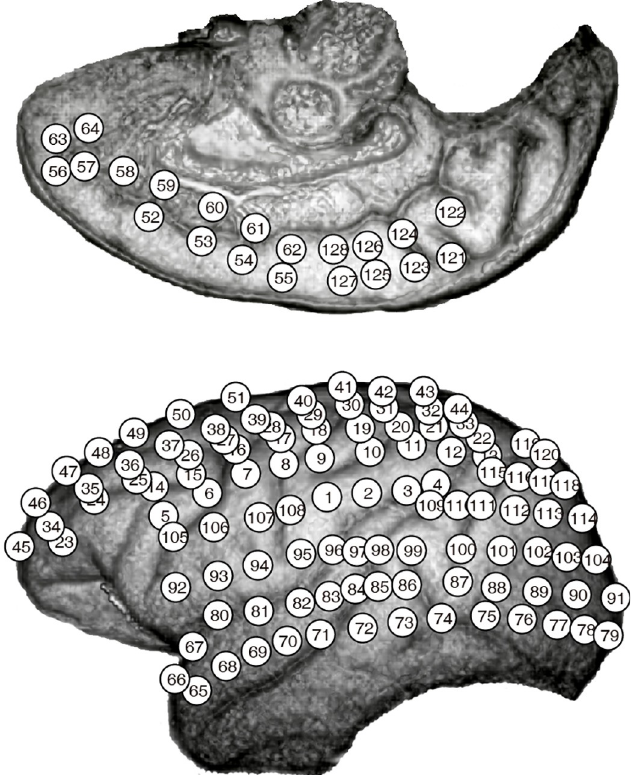
Fig 1. Recording array map. The placement of recording arrays for Chibi. Image taken from the NeuroTycho website, http://neurotycho.org/spatial-map-ecog-array-task.